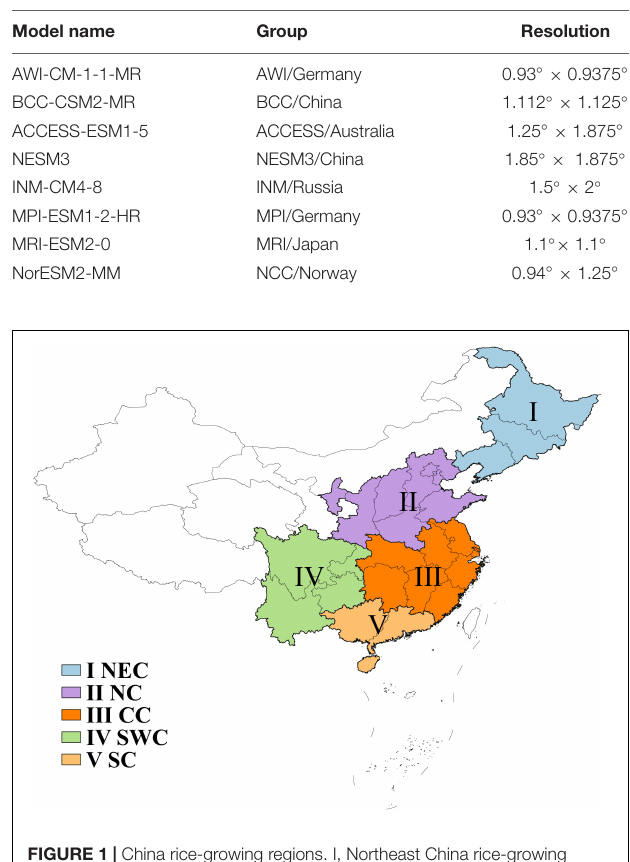
TABLE 1 | Basic information and atmospheric resolution of eight CMIP6 global climate models.